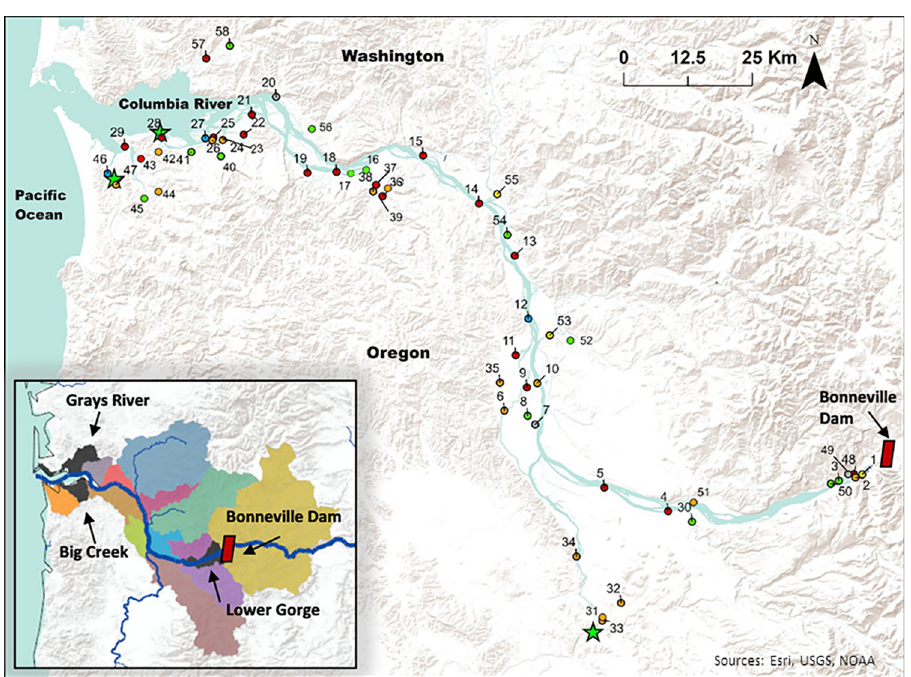
Fig 2. Water sample locations for Ceratonova shasta in the Columbia River Basin, March 15 –May 1, 2018, April 15 –May 15, 2019, and April 15 –May 15, 2020. Markers are labeled with the site code in Tables 1 and 2. Marker color indicates the genotypes of C . shasta that were detected (green = no C. shasta, yellow = genotype I, red = genotype II, orange = genotypes I and II, grey = C . gasterostea , and blue = sample could not be genotyped). Green stars indicate sites where sentinel cages were held (Lewis and Clark at site 46, Tongue Point at site 28, and Willamette at site 33). Inset shows boundaries for 17 historical populations; chum salmon Oncorhynchus keta were collected for the sentinel study from the Grays River, Big Creek, and Lower Gorge Populations (shown in black). Topographic basemap was created by Esri, USGS, and